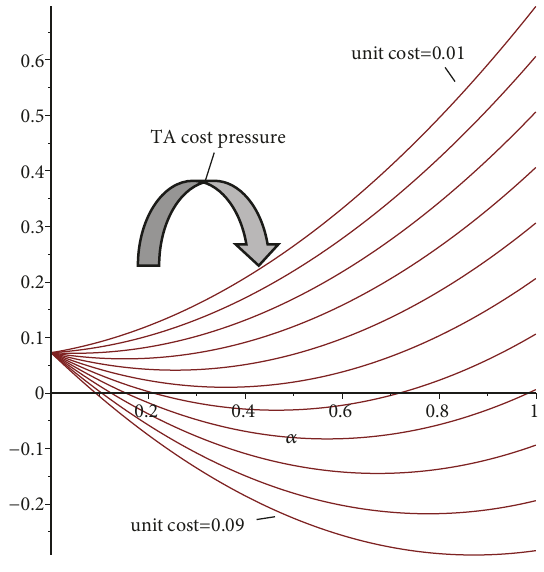
Figure 8: Expected profit under different TA cost